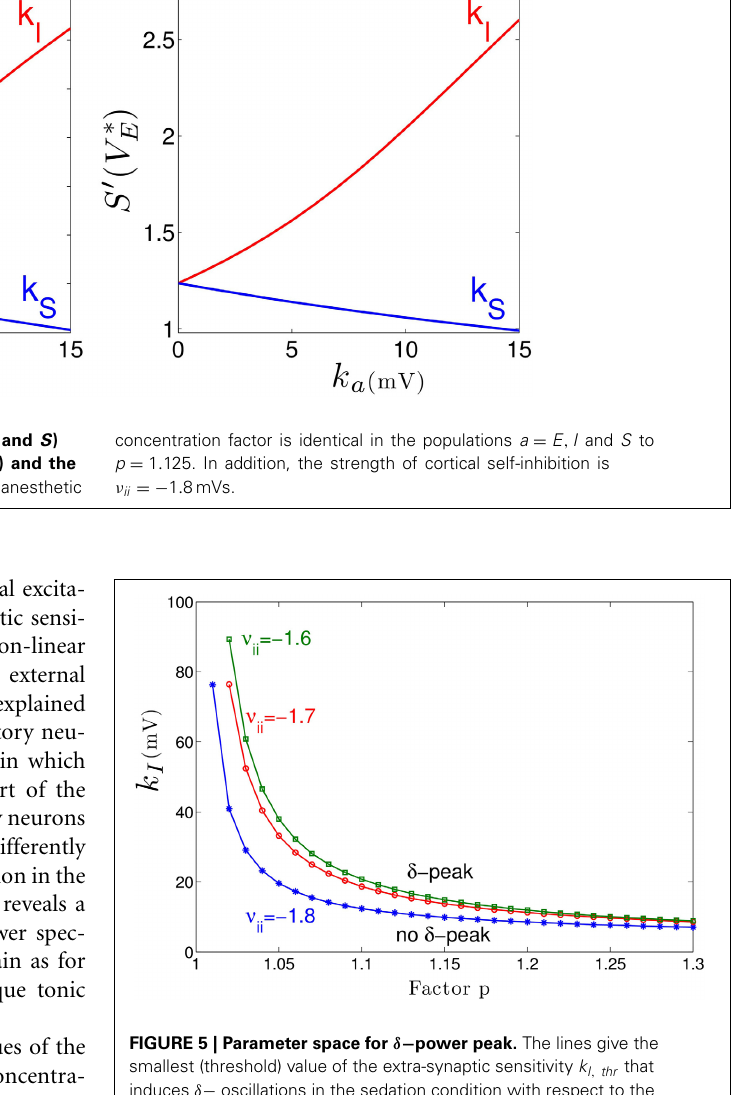
FIGURE 5 | Parameter space for δ − power peak. The lines give the smallest (threshold) value of the extra-synaptic sensitivity k I , thr that induces δ − oscillations in the sedation condition with respect to the concentration factor p for different values of self-inhibitory connections ν ii . The weaker the cortical self-inhibition (the smaller | ν ii | ), the higher the necessary level of propofol concentration (larger p ) and the tonic inhibition [larger ( p − 1) · k I ] to induce δ −